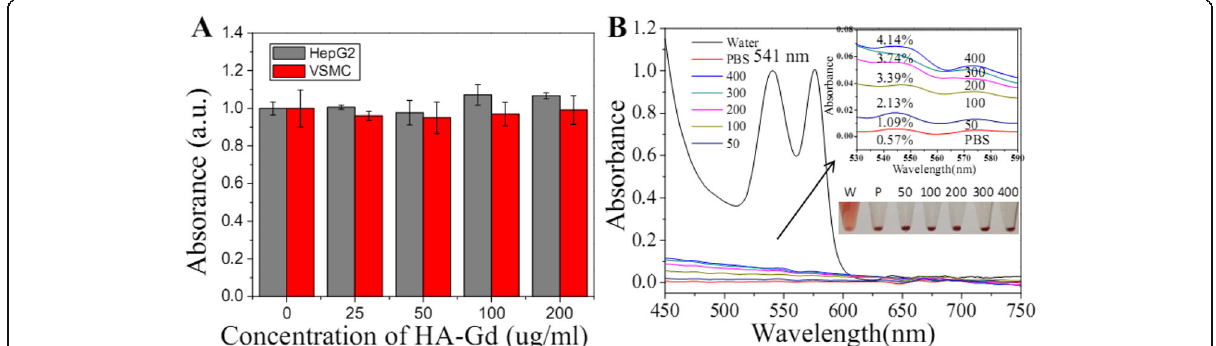
Fig. 3 a Effect of HA-Gd 2 O 3 NPs on the viability of HepG2 and VSMC cells using the CCK-8 assay. b Hemolytical activity of the HA-Gd 2 O 3 NPs at different concentrations (50, 100, 200, 300, and 400 μ g/mL). PBS and water were used as the negative and positive control, respectively